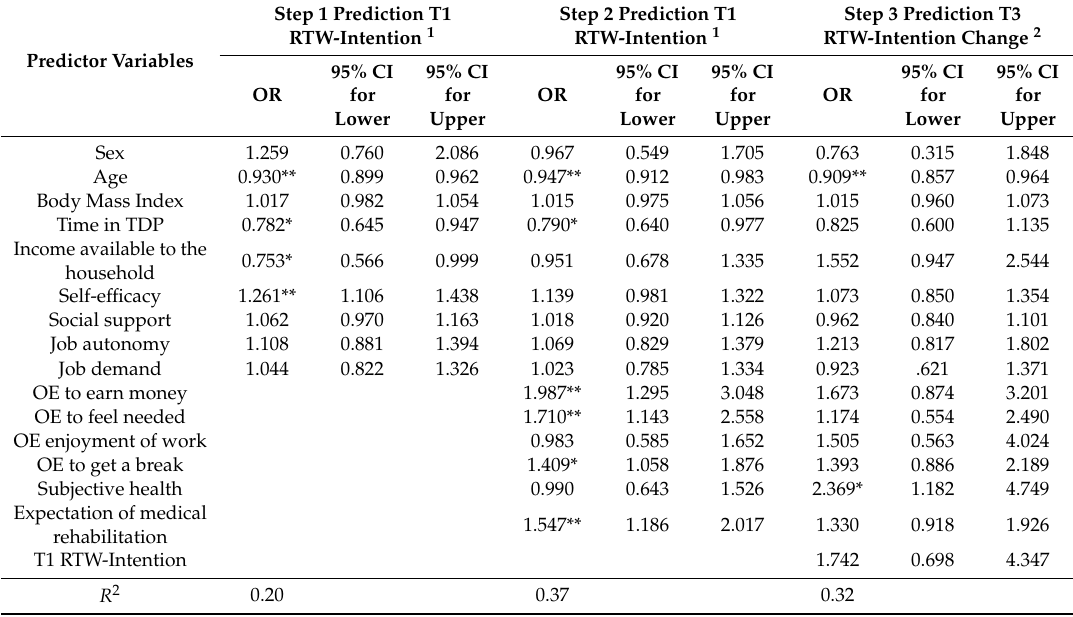
Table 3. Prediction of RTW-intention (low vs. high) with binary-logistic regression analyses.